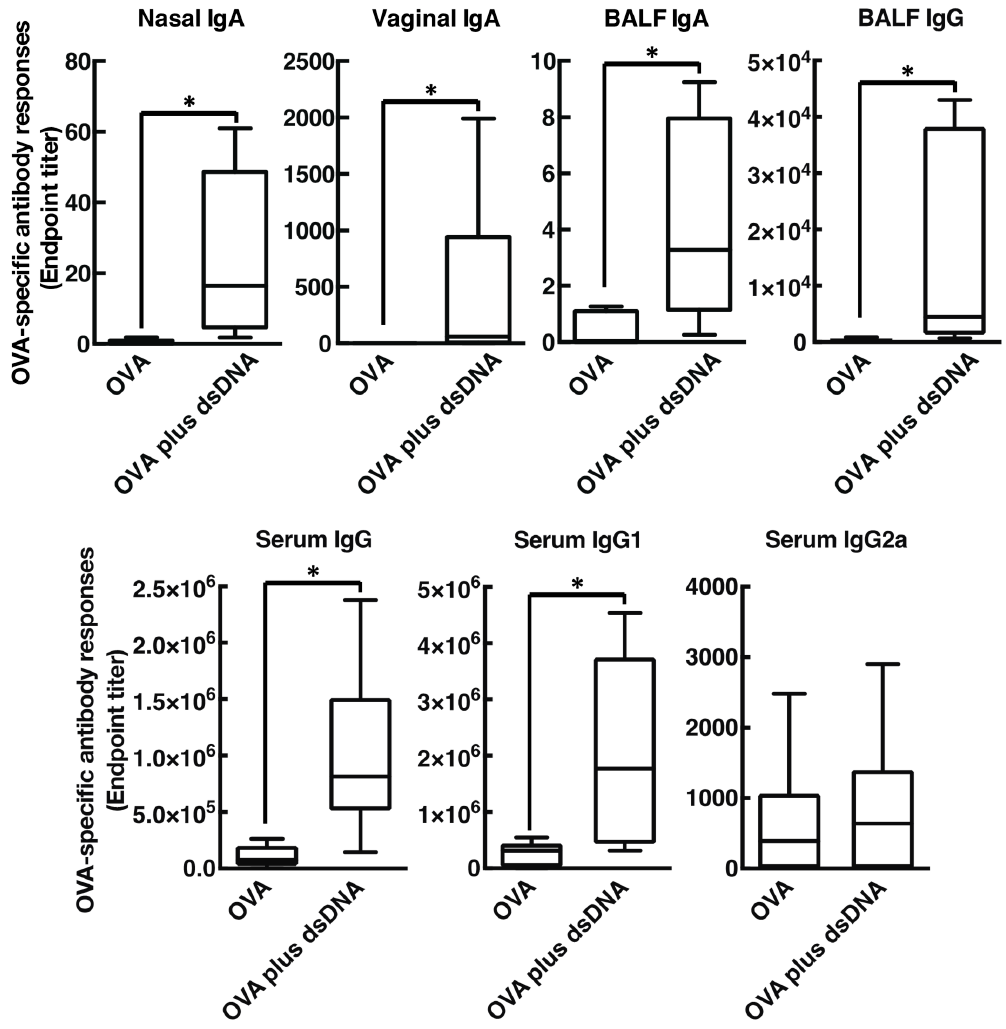
Figure 4. Host dsDNA prepared from BALB / cCrSlc mice potentiate antigen-specific mucosal and systemic antibody responses. BALB / cCrSlc female mice were immunized intranasally (days 0, 7, and 14) with PBS, OVA (2.5 µ g / mouse) alone, or OVA (2.5 µ g / mouse) together with dsDNA (50 ng / mouse). OVA-specific nasal IgA, vaginal IgA, BALF IgA, BALF IgG, serum IgG, serum IgG1, and